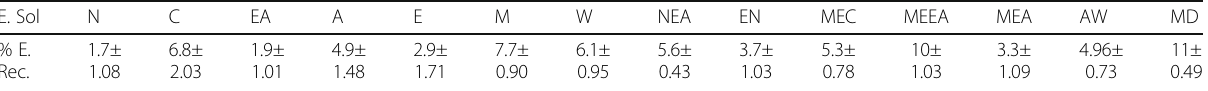
Table 1 Percent extract recovery of A. lasiantha extracts through different extraction solvents E. Sol N C EA A E M W NEA EN MEC MEEA MEA AW % E.